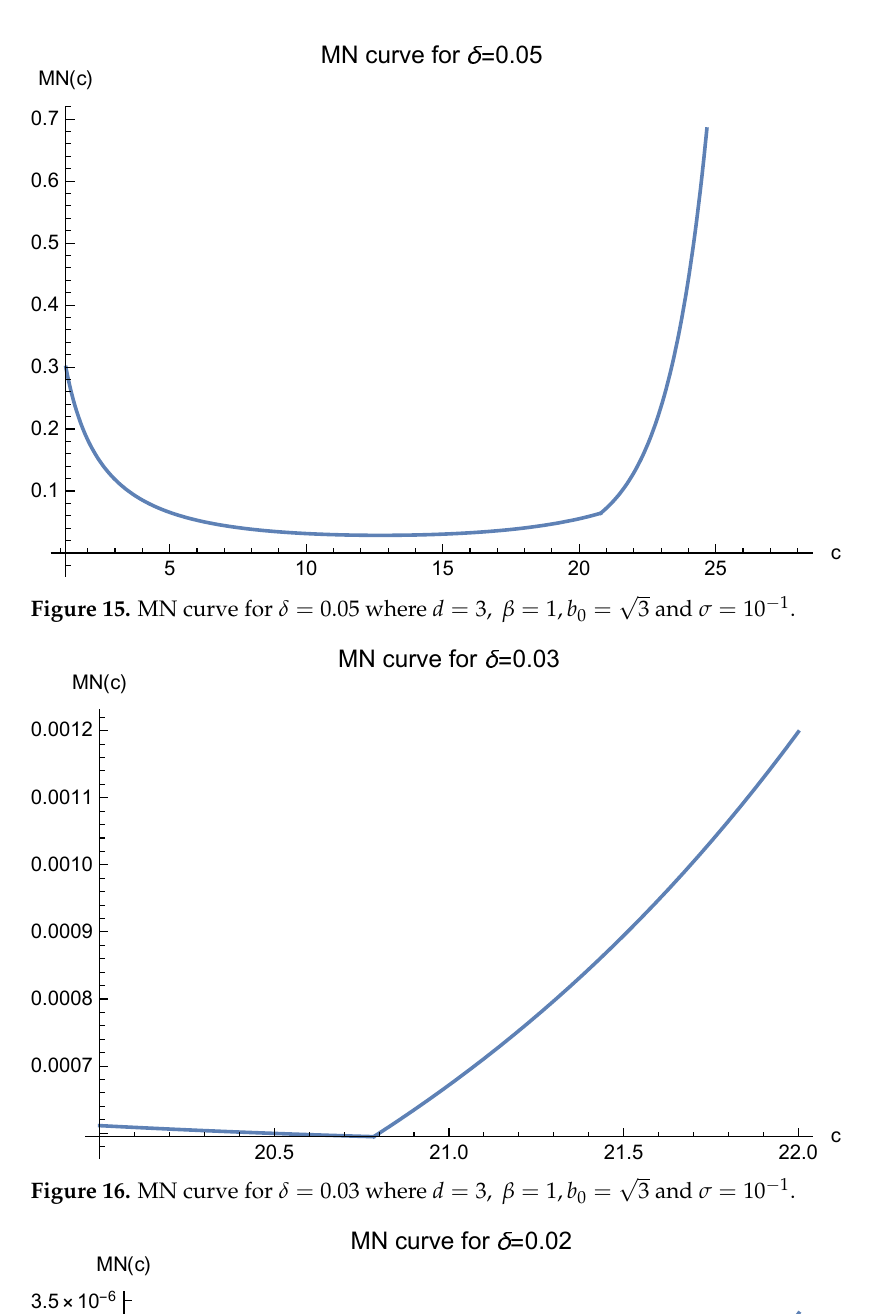
Figure 16. MN curve for δ = 0.03 where d = 3, β = 1, b 0 =